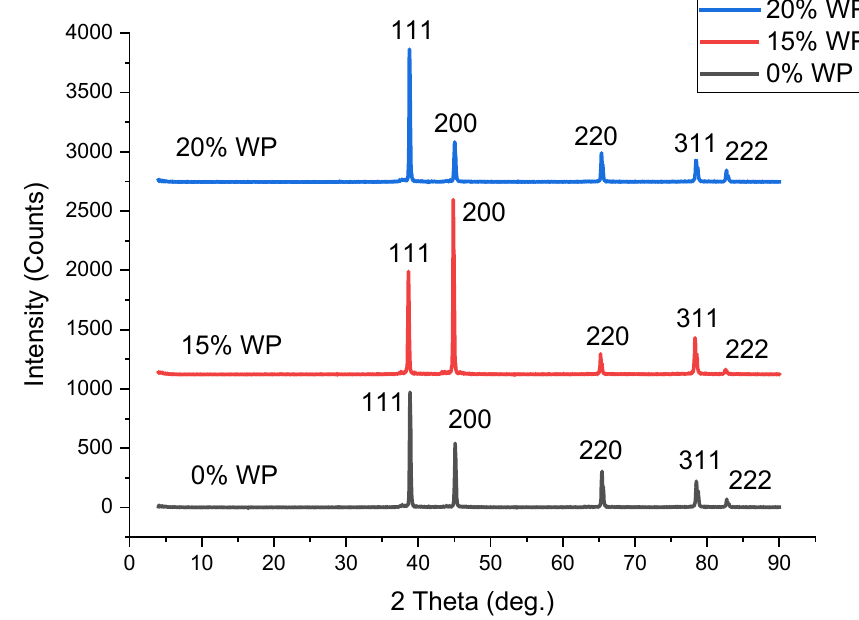
Figure 8. XRD pattern of composite material.